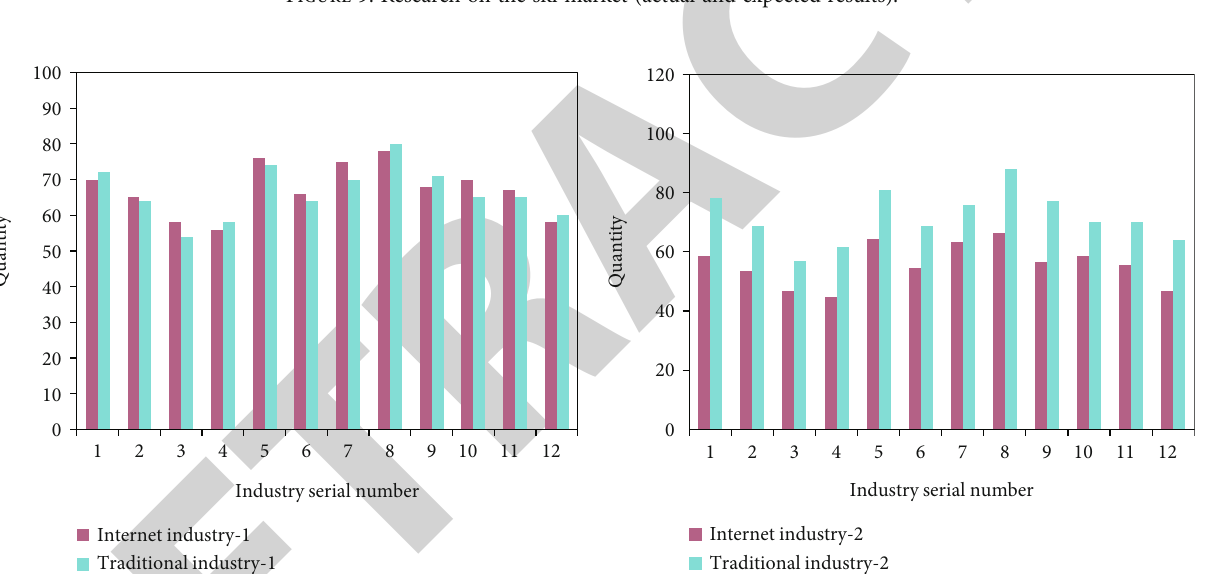
Figure 9: Research on the ski market (actual and expected results).